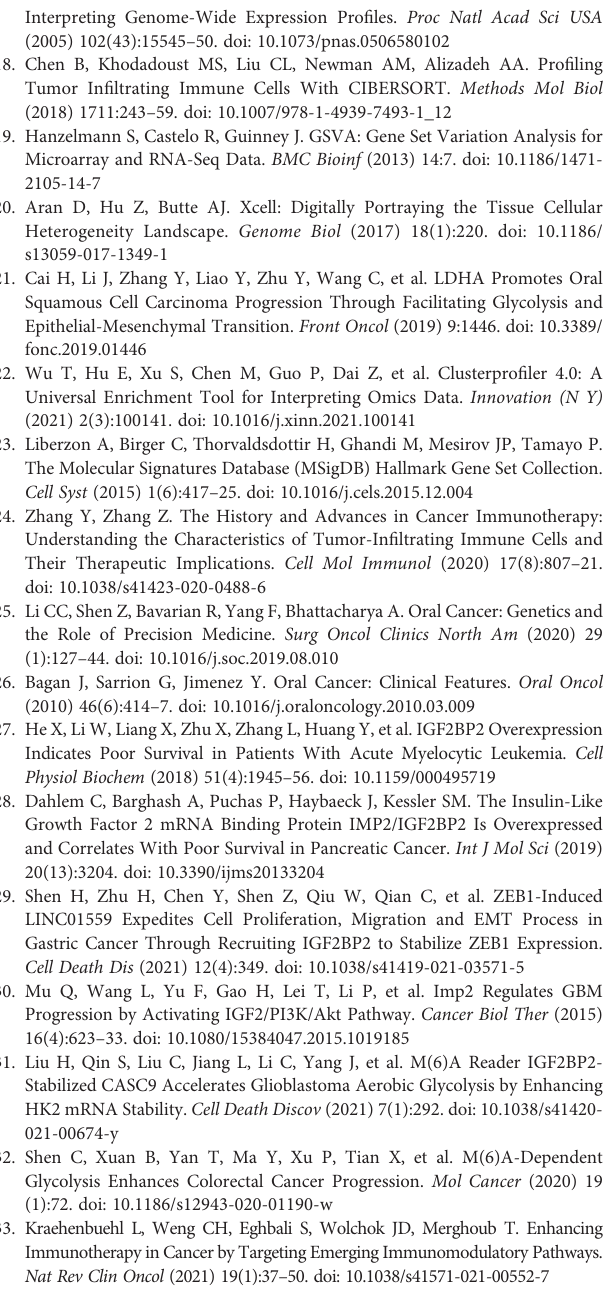
Supplementary Data Sheet 1 | Genes in the green module for TCGA-OSCC dataset. Supplementary Data Sheet 2 | Genes in the turquoise module for the GSE30784 dataset. Supplementary Data Sheet 3 | DEGs between OSCC and normal samples in TCGA-OSCC dataset. Supplementary Data Sheet 4 | DEGs between OSCC and normal samples in the GSE30784 dataset.